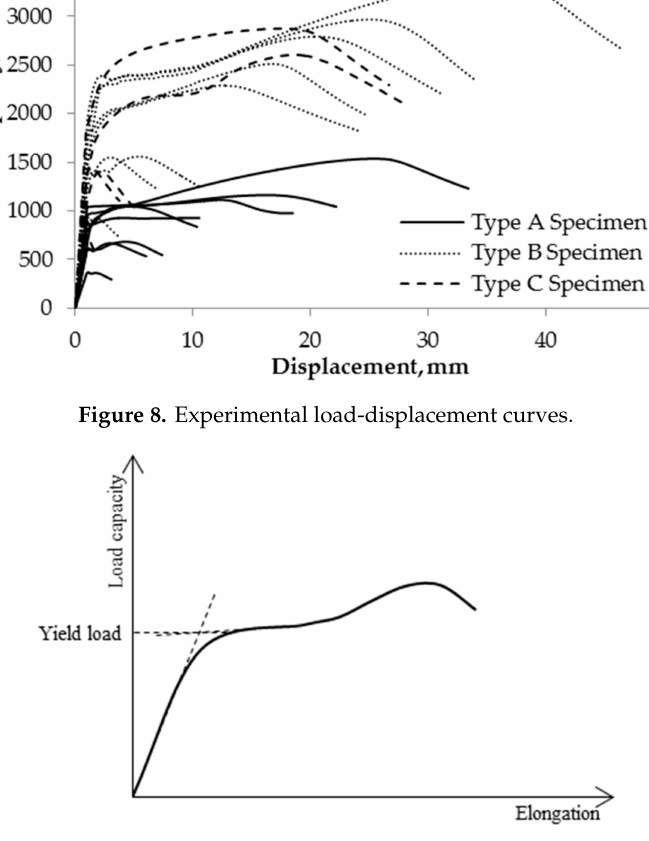
Figure 9. Coplan’s yield point method. Table 4. Comparison of experimental and numerical